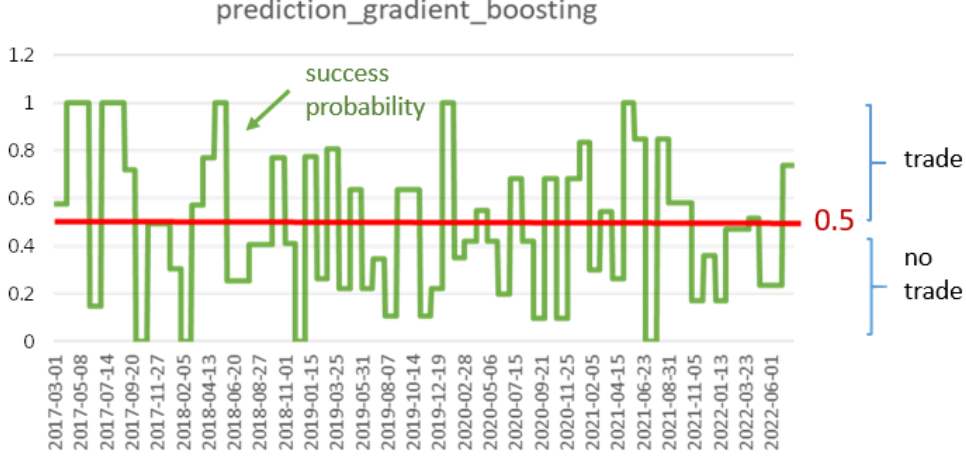
Figure 11. Trading probabilities (green line) for the gradient-boosting